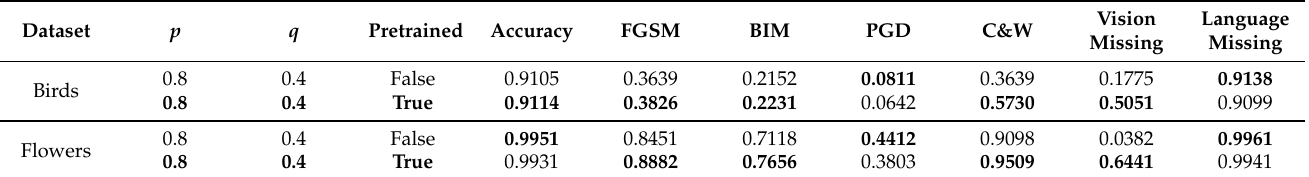
Table 10. The effect of pre-training of the language feature extraction module on various aspects of the